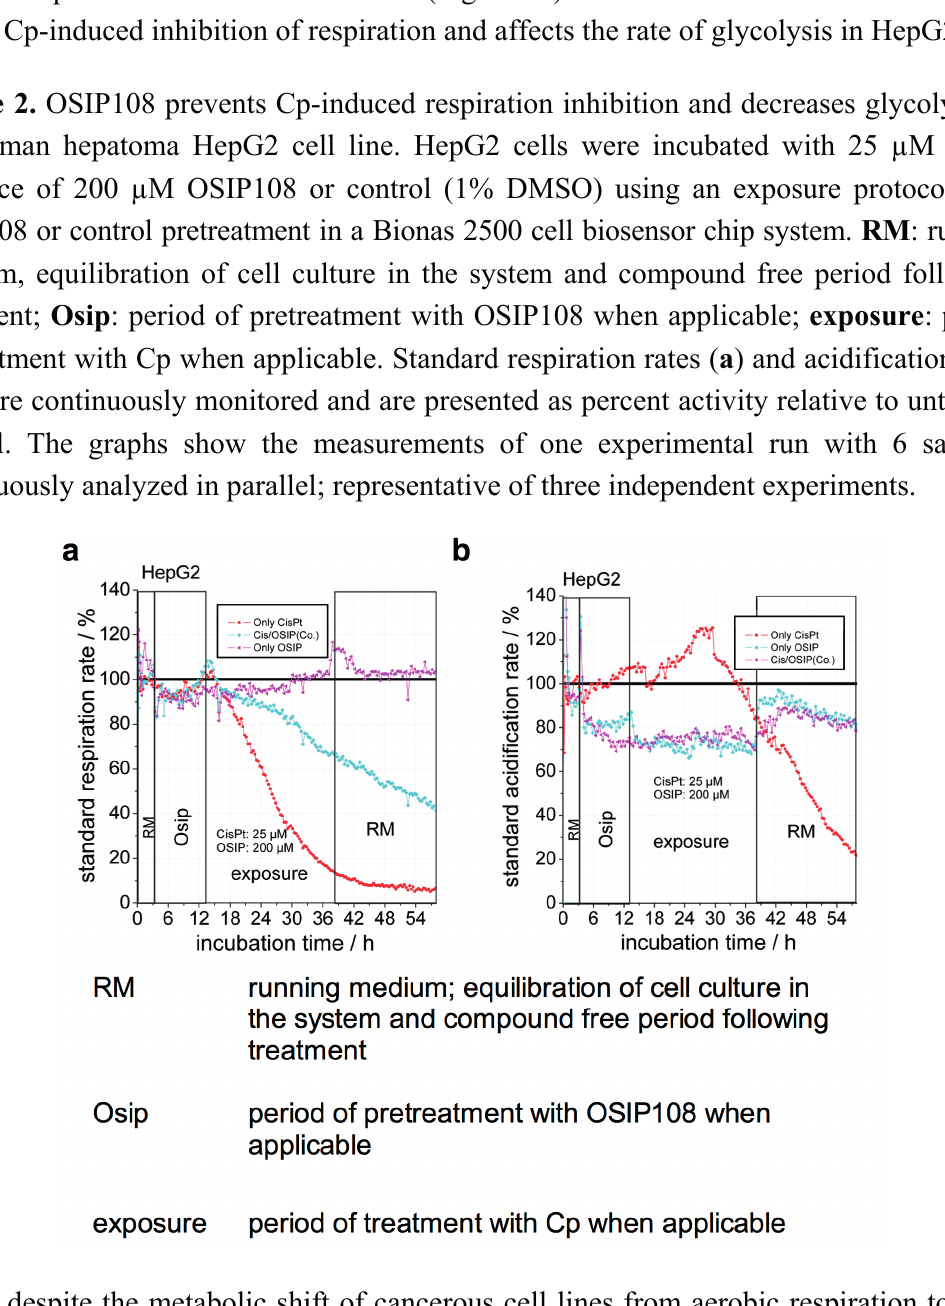
the human hepatoma HepG2 cell line. HepG2 cells were incubated with 25 µM Cp